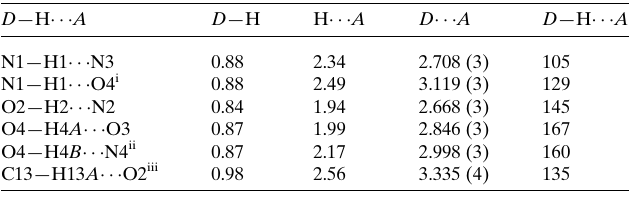
Table 1 Hydrogen-bond geometry (A˚ , (cid:3) ).